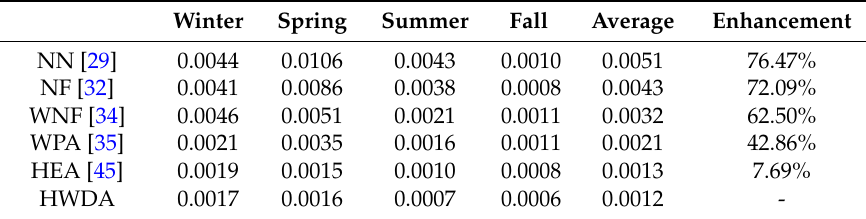
Table 7. Daily error variance comparison for wind power forecasting. Winter Spring